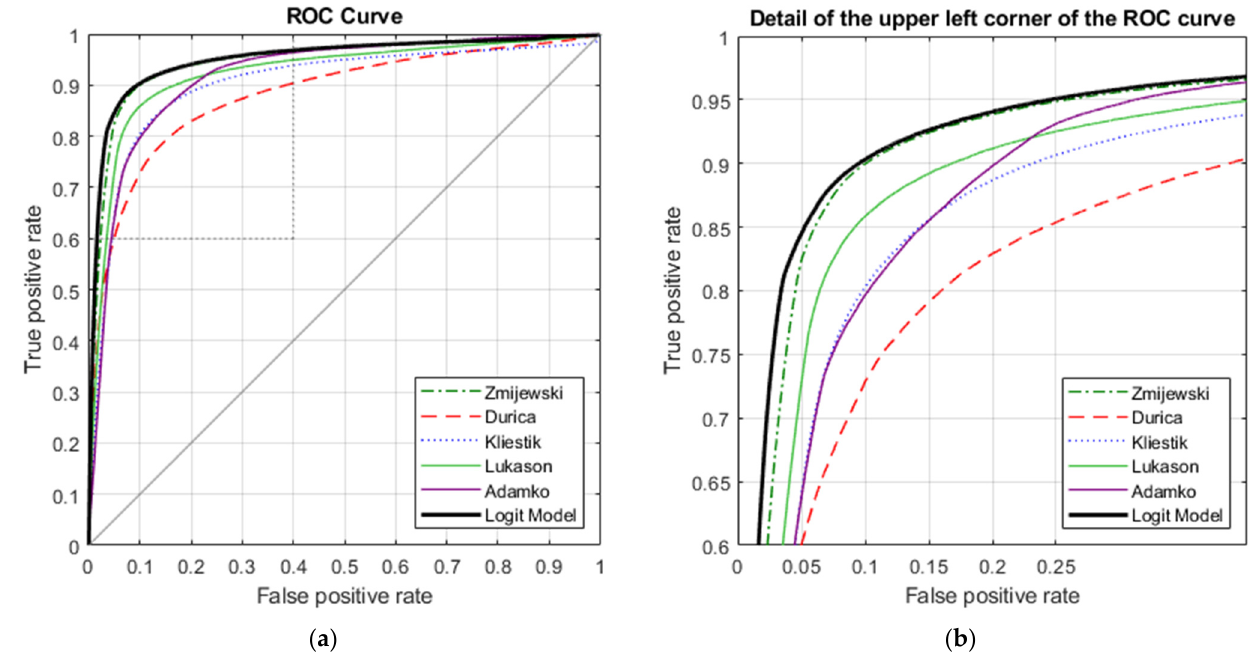
Figure 6. ROC curves of compared models. ( a ) The shape of ROC curves on the whole interval, ( b ) the detail of the ROC curves. Table 9. Performance metrics of compared models on the testing sample.